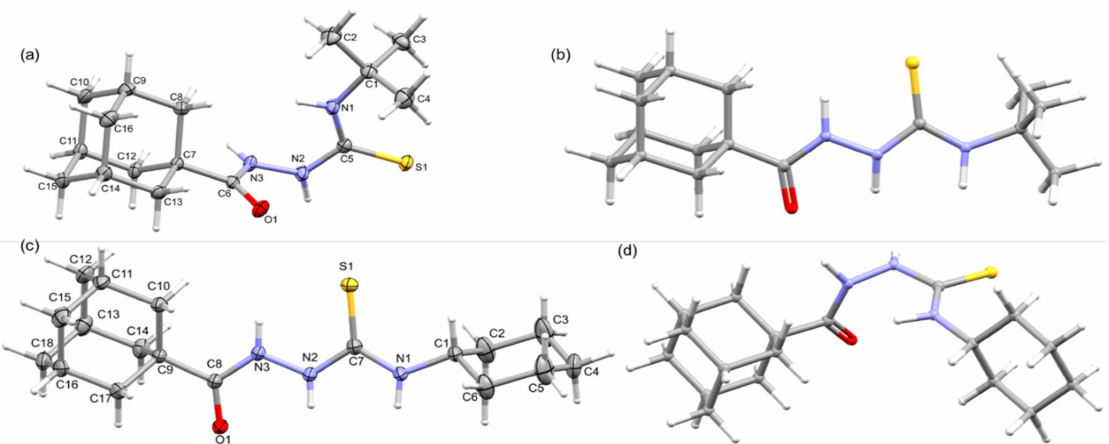
Figure 1. Thermal ellipsoid plot of ( a ) compound 1 and ( c ) compound 2 , drawn with 50% probability level, ( b ) the optimized structure of 1 in conformation of 2 (conformer 1a), and ( d ) the optimized structure of 2 in conformation of 1 (conformer 2a).